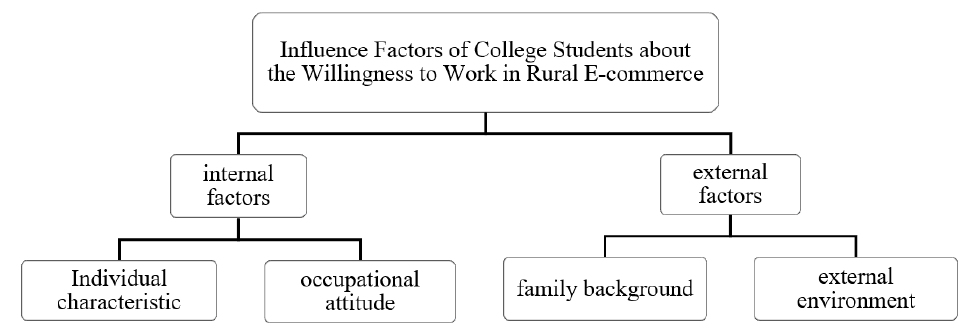
Fig. 1 Influence Factors dimension division